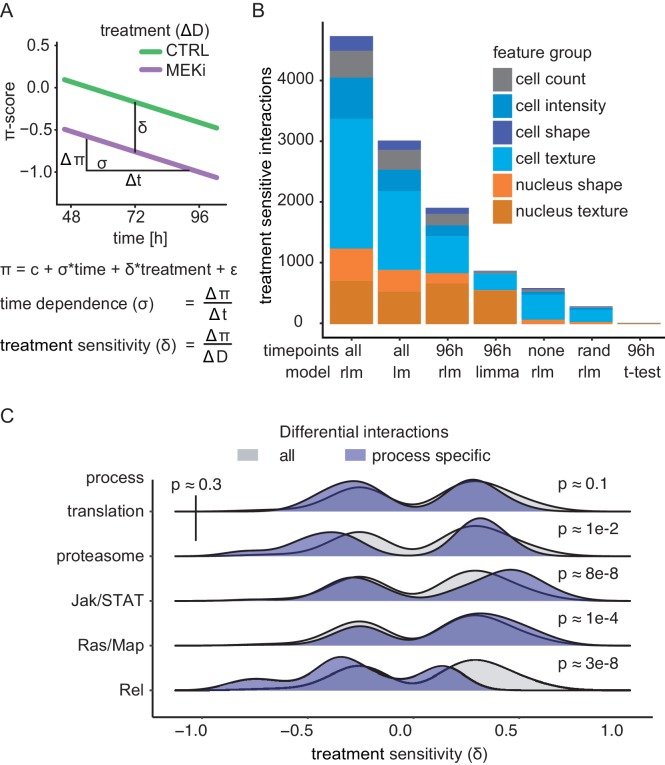
Robust linear models describe the continuity of genetic interaction rewiring.(A) Derived measures from the interaction model: the time dependence (σ) of interaction development, treatment sensitivity (δ) of response to MEKi and average initial interaction difference. (B) Differential interactions detected depending on the used data and model. Significant (FDR < 0.1) differential interactions were counted when analyzed using a linear model (lm), a robust linear model (rlm), a moderated t-test (limma) or Welch’s t-test. End-point, sequential and randomized data were compared. The analysis was carried out for all features and accumulated counts are shown. ‘none’ means that all time points were treated as replicates of the same measurement. ‘rand’ means that measurements were assigned to random time points and 96 hr denotes the data treated as end-point measurements of the last time point. All models tested the null hypothesis that there is no difference between treatments. A two-sided Welch’s t-test was used. The robust linear model (rlm) coefficient’s significance was estimated using robust F-tests. The significance of the linear model coefficient was tested by two-way ANOVA. (C) Measurement of sensitivity toward MEKi. The treatment sensitivity was assessed by comparing δ between biological processes. Significance was tested by a two-sided Kolmogorov-Smirnov test of the sample against all measured interactions. Resulting p-values are indicated. Upper-left p-value compares process specific δ between translation and proteasome.